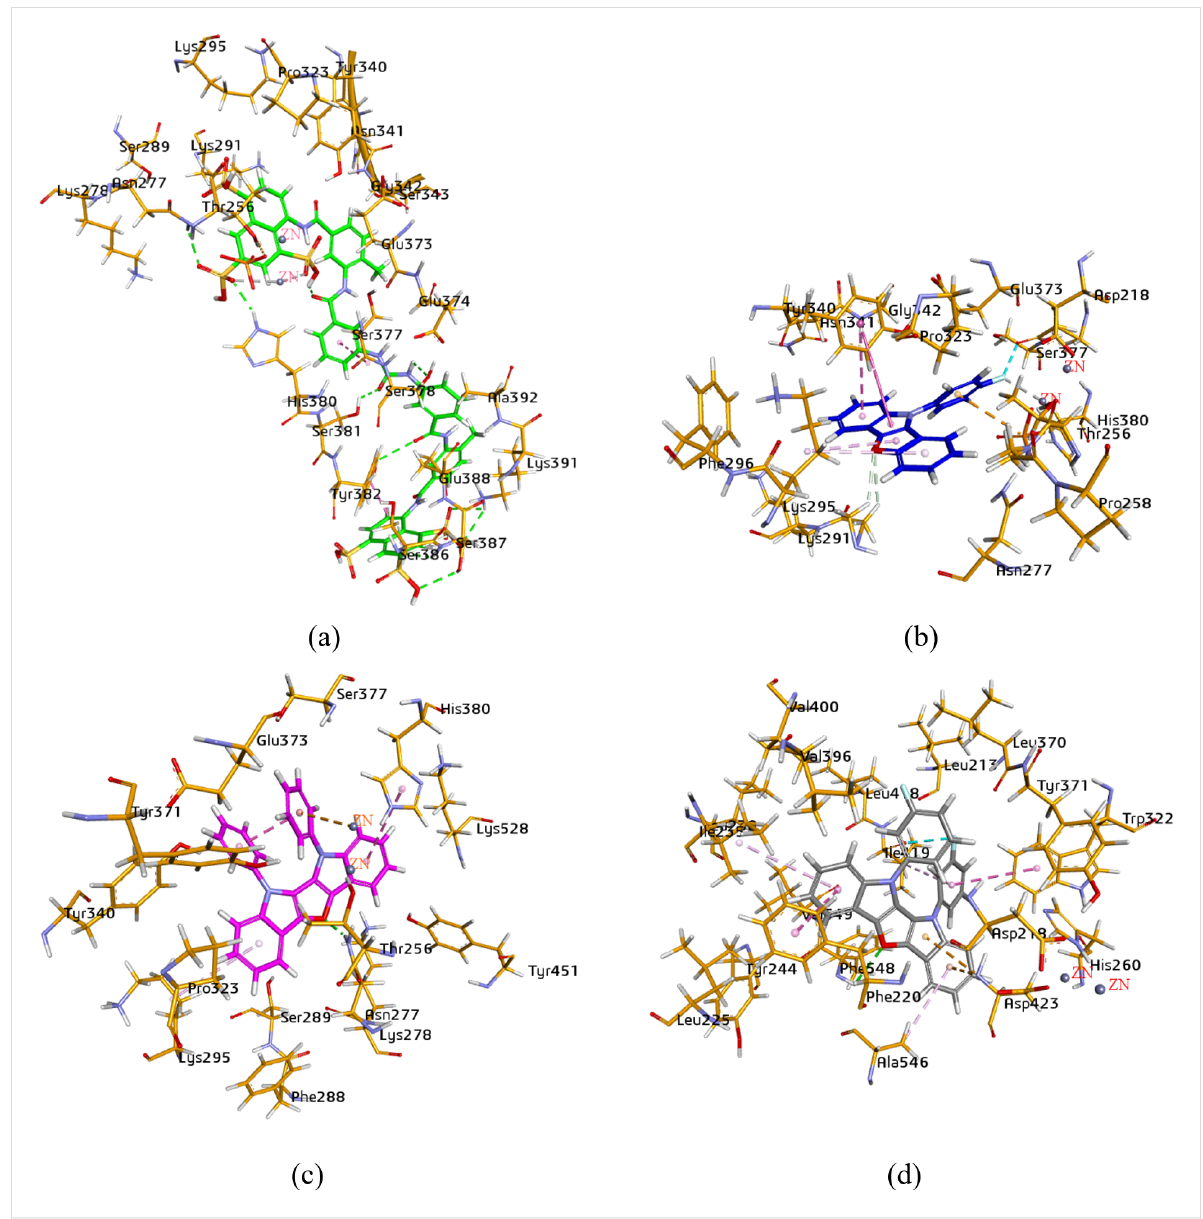
Figure 4: Illustration of binding poses of selected inhibitors for the ENPP1 homology model: (a): suramin, (b): 5c , (c): 6a , (d): 6e